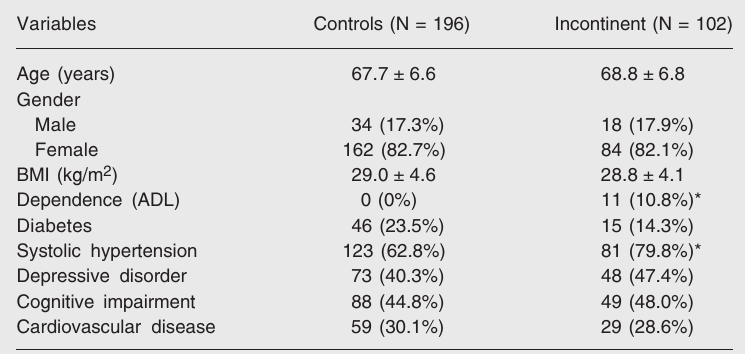
Table 1. Baseline characteristics and common geriatric problems among urinary incontinence case-control subjects.